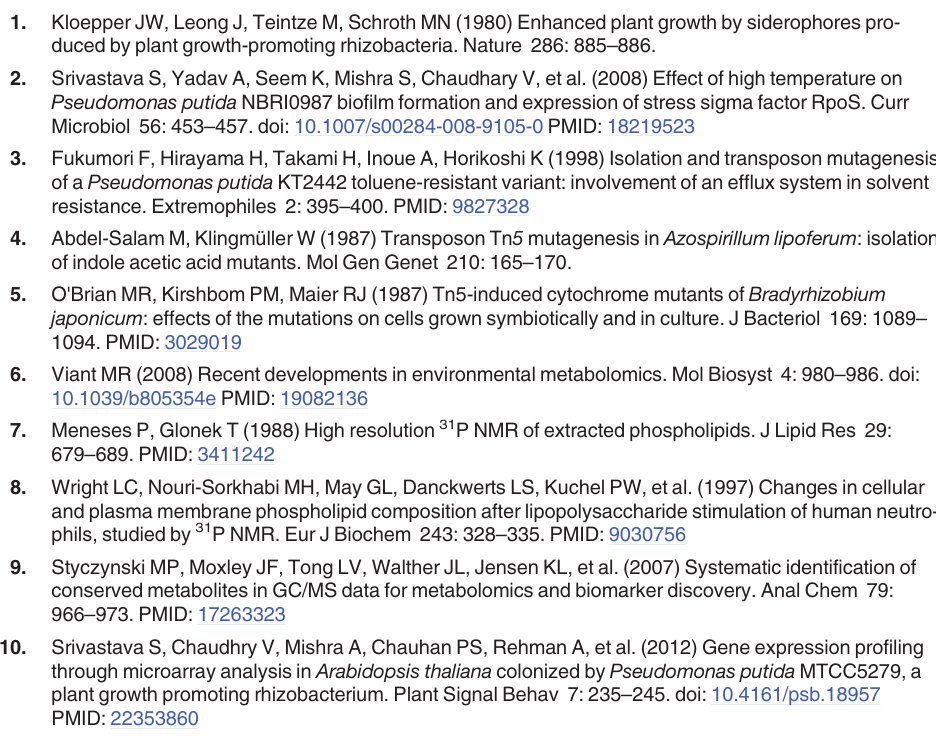
S4 Fig. Stack-plot of 31 P NMR spectra. P. putida NBRI1108 (A) and NBRI1108T (B). S5 Fig. Proton NMR spectra of lipids extract of P. putida cells showing detection of GPC and GPE. NBRI1108 (A) and NBRI1108T (B). S6 Fig. Simplified metabolic map displaying biosynthetic pathways for PC in P. putida . Metabolites denoted with star have shown significant changes in